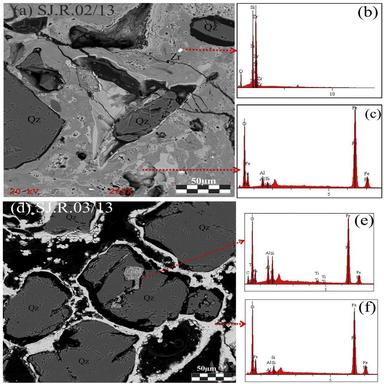
Photomicrographs obtained by MEV and chemical analysis obtained by EDS of small aliquots subtracted from FSJM ferruginized sandstone: in the SJ.R.02/13 sample (a) quartz grains (Qz) immersed in Fe hydroxide cement, and ferric goethite, possibly containing relics of kaolinite in goethite cement (c) beside a rare zircon grain (Zr) (b). Below, an aliquot of the SJ.R.03/13 sample (d) showing quartz grains (Qz) with corrosion edges of Fe hydroxide (ferric goethite) and a possible relict inclusion of kaolinite in